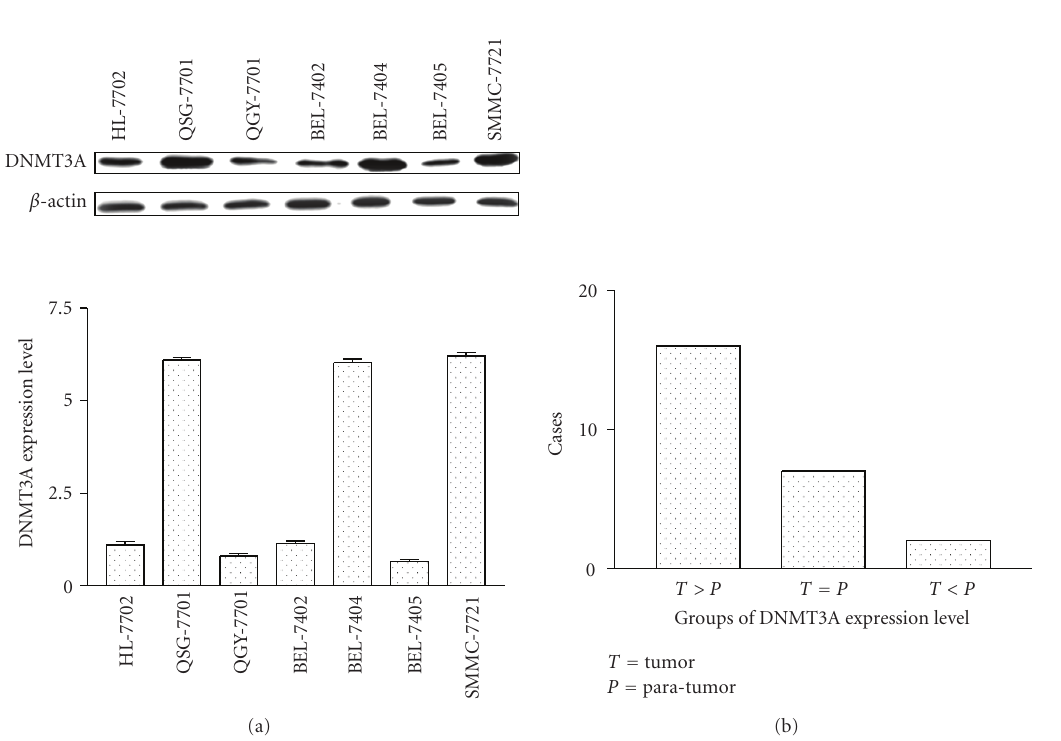
Figure 1: DNMT3A expression is analyzed in HCC cell lines, HCC tumor tissue, and adjacent nontumor samples. (a) DNMT3A protein expression level was detected in HCC cell lines by western blot. Upper panel, DNMT3A was examined by western blot in HCC cell lines. Bottom panel, the intensity ratios of both target gene band and control from the same sample were determined and calculated by Gel- Pro Analyzer 3.0 . DNMT3A was increased more in 3 HCC cell lines than in immortalized normal liver cell line HL-7702. (b) Real-time quantitative RT-PCR analysis of DNMT3A expression in 25 pairs of HCC specimens and adjacent noncancerous liver tissues, normalized to β -actin